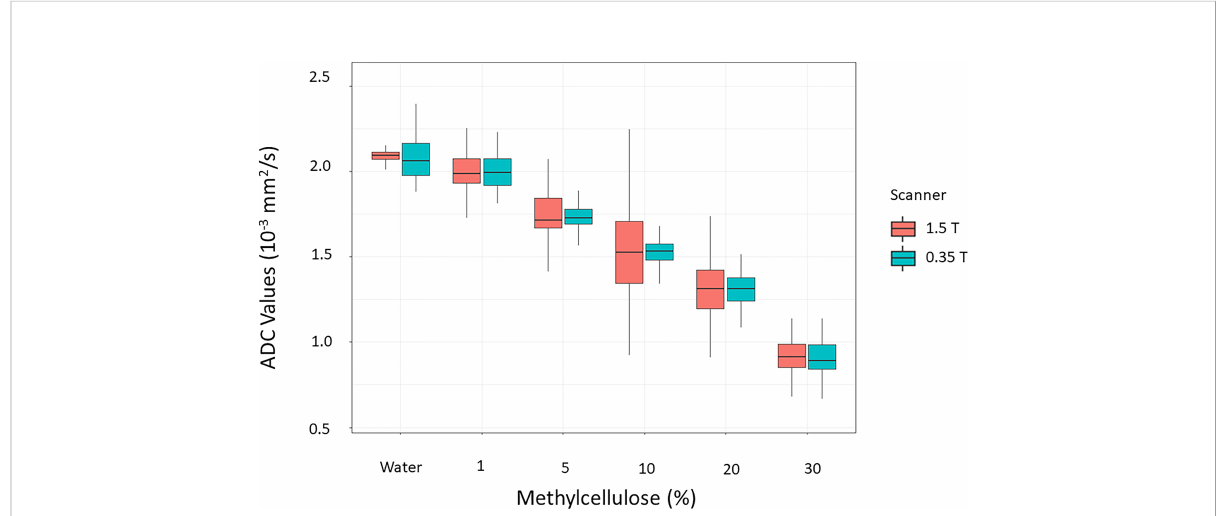
FIGURE 6 Distributions of the values of the ADC coef fi cients calculated from the images acquired on the scanner at 0.35 T (cyan box) in comparison with those acquired with a homologous sequence on a diagnostic scanner at 1.5 T (orange box) for the various concentrations of the methylcellulose solutions present in the HMP.